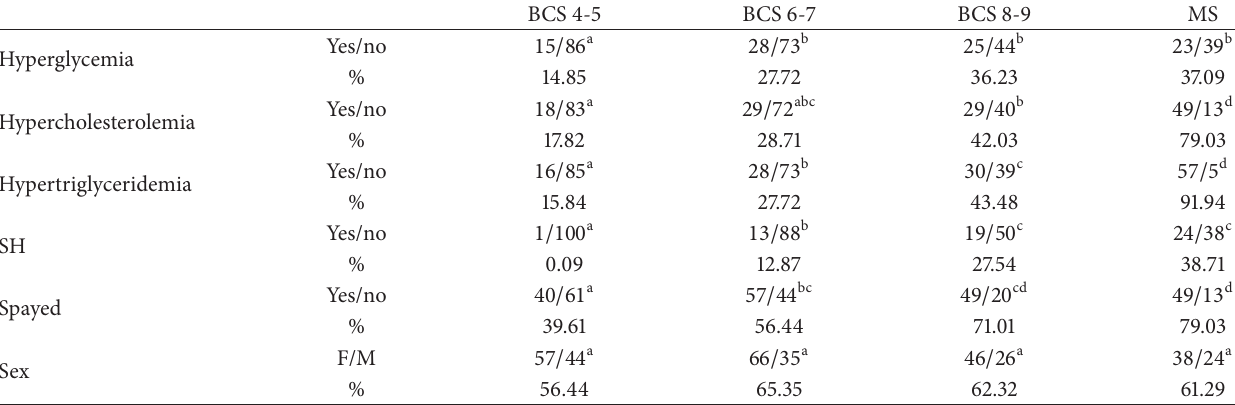
Table 3: Absolute frequency and relative hyperglycemia ( > 100mg/dL), hypercholesterolemia ( > 300mg/dL), hypertriglyceridemia ( > 200mg/dL), hypertension ( > 160mmHg), castration, and sex in 271 dogs grouped according to body condition and inclusion criteria for